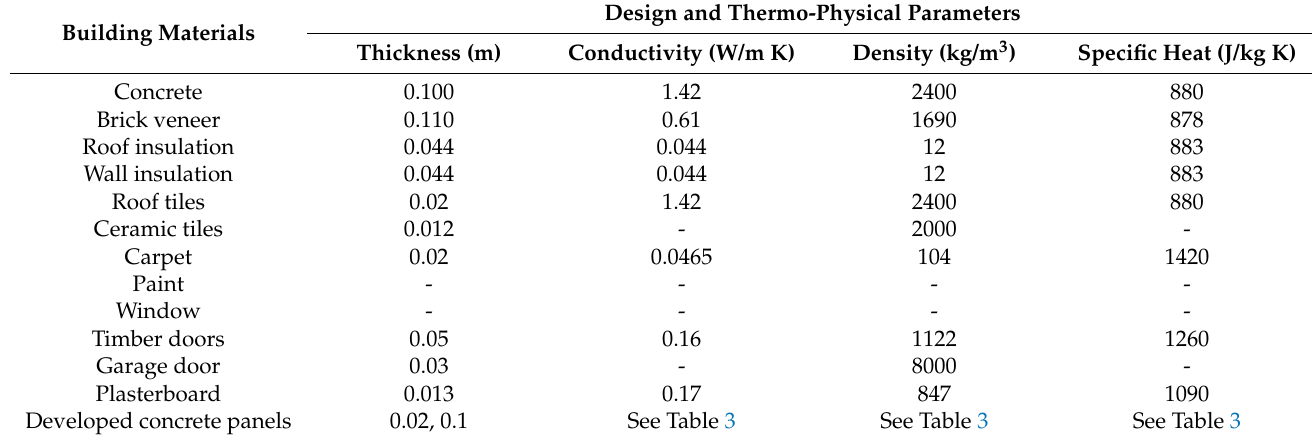
Table 2. Thermo-physical properties of building materials [25].